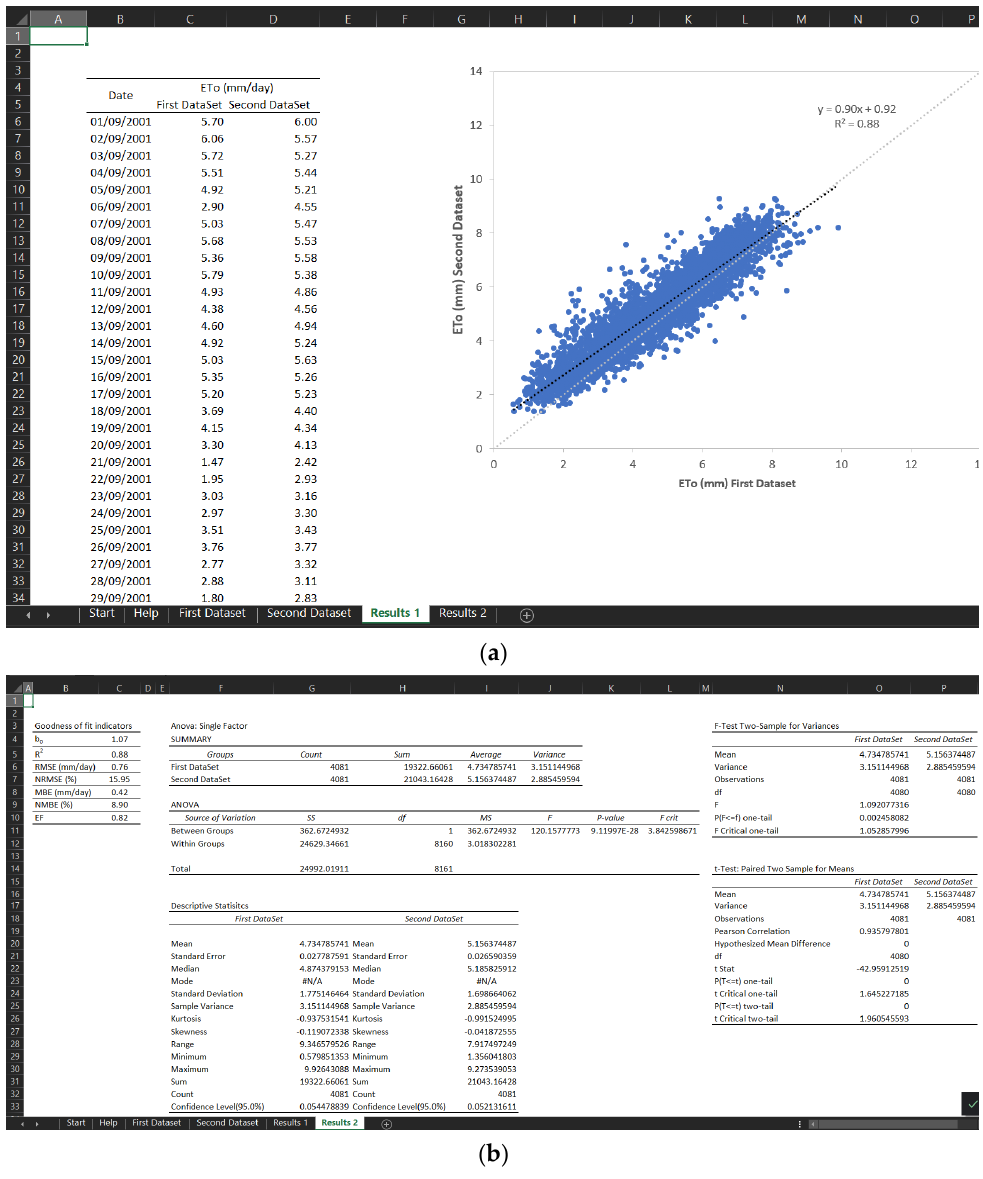
Figure 4. ETo Tool interface: ( a ) computed results and scatter plot; ( b ) accuracy indicators and statically analysis.